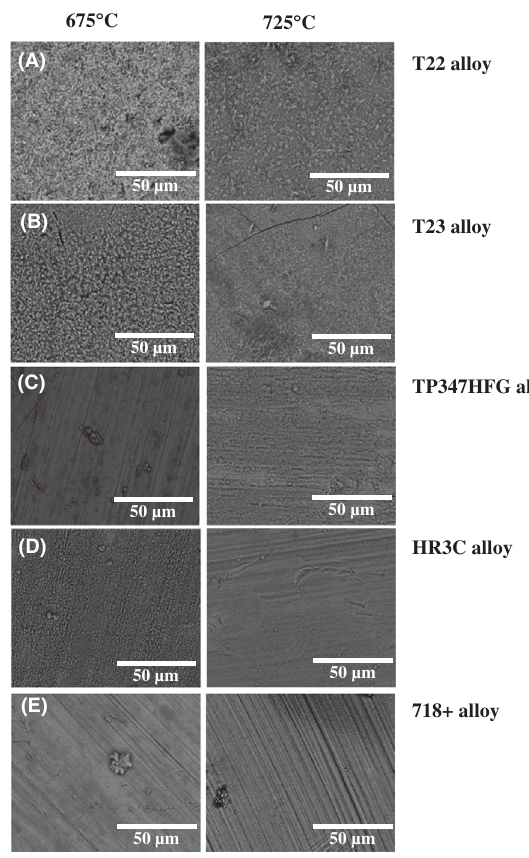
Figure 6: A comparison of the scale morphologies formed on the exposed materials after 500 h at 675°C and 725°C: (A) T22, (B) T23, (C) TP347HFG, (D) HR3C and (E) 718 þ